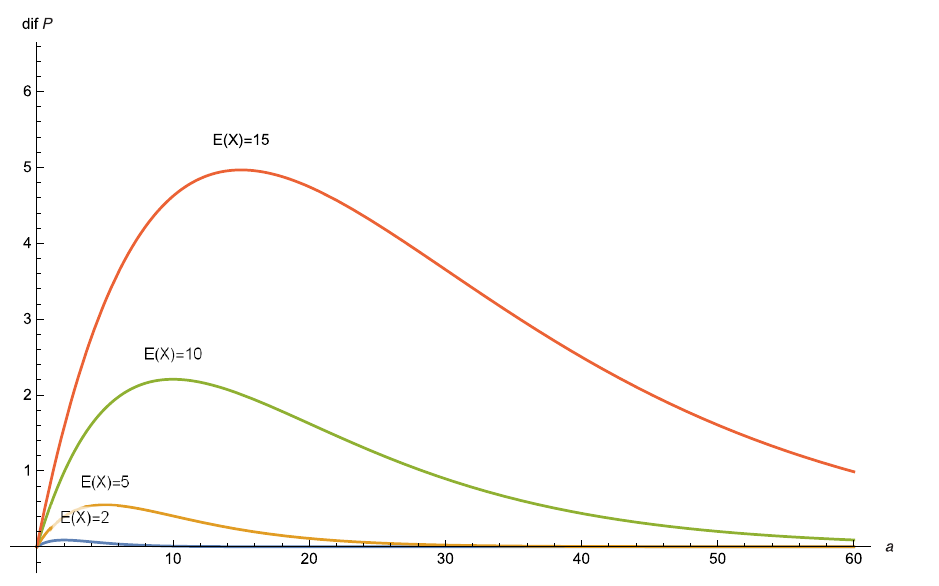
Fig 1. dif ( F ) as a function of a in the Poisson-exponential case for δ = 0.03 and λ = 1 for E ( X ) = 2, 5, 10, 15.